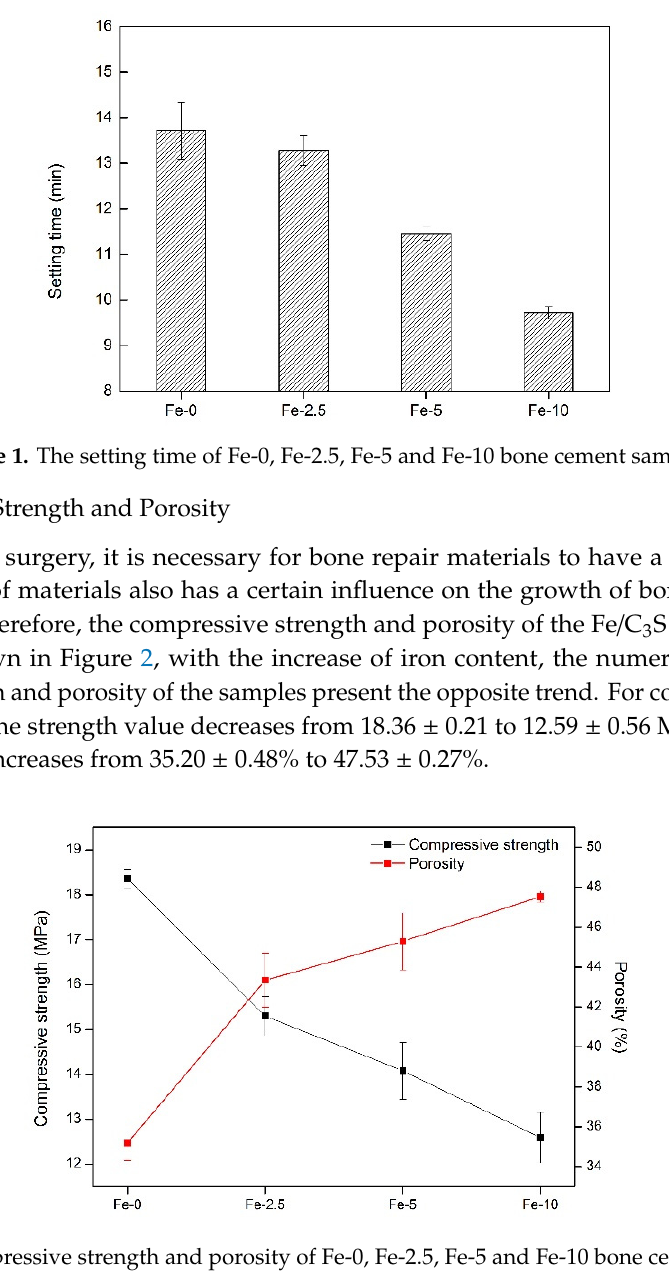
Figure 2. Compressive strength and porosity of Fe-0, Fe-2.5, Fe-5 and Fe-10 bone cement samples.